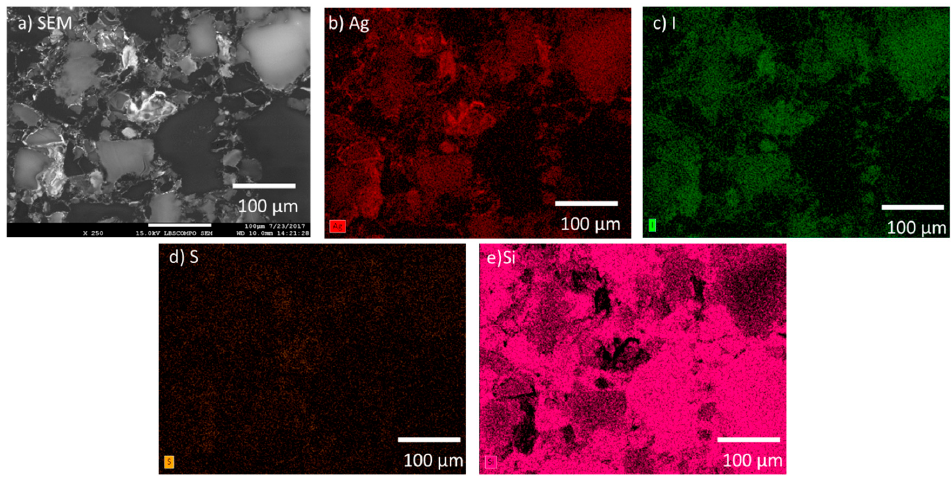
Figure 5. Microstructure of the SPS-1 sample shown by: ( a ) SEM micrograph; and the corresponding EDS maps of: ( b ) Ag; ( c ) I; ( d ) S; and ( e ) Si.